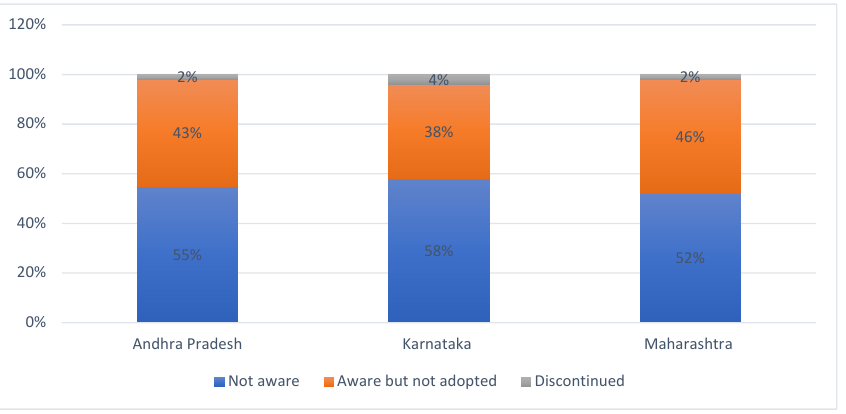
Figure 6. Awareness about NF among non-NF farmers (in % of non-NF farmers surveyed).